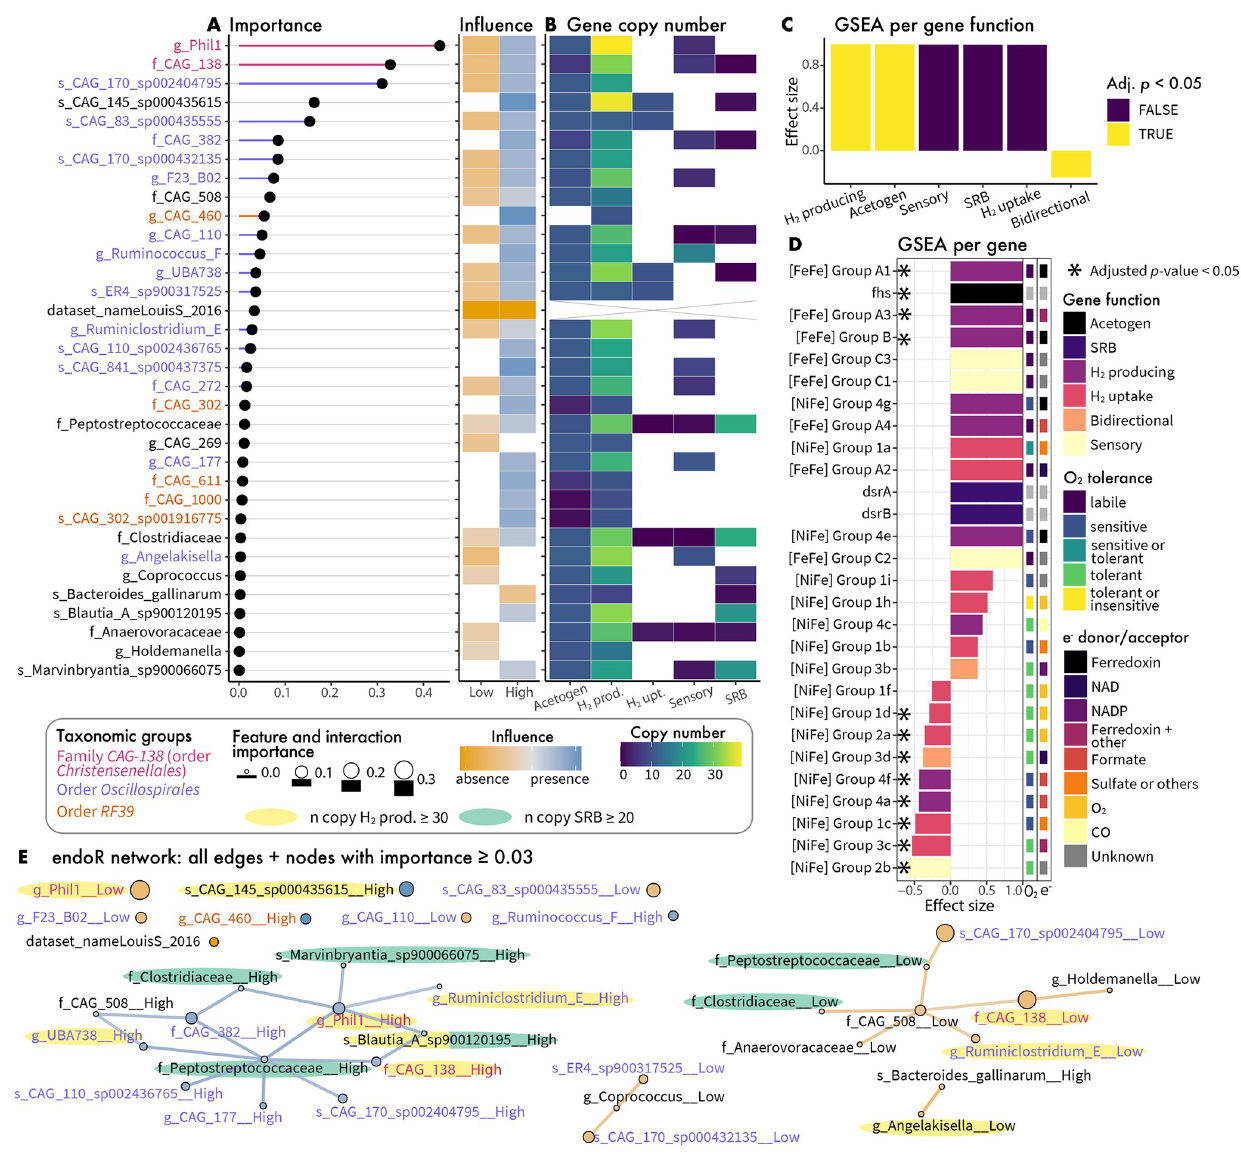
Fig 6. Relative abundances (RA) of Oscillospirales , Christensenellales and other select bacteria predict conditions favorable to colonization of the human gut by Methanobacteriaceae . A: Feature importance and influence for each taxa used by the decision ensemble generated by endoR. Taxonomic levels are indicated with label prefixes: ‘f_’ = family, ‘g_’ = genus, and ‘s_’ = species, while taxonomic orders are indicated via bar and label colors. Levels correspond to ‘Low’ and ‘High’ relative abundances of taxa. B: Sum of gene copy numbers of marker genes involved in H 2 production and consumption (see Methods and S5 Table), for endoR selected features. SRB: dsrA and dsrB genes exclusively involved in sulfate reduction [82]; Acetogen: fhs gene involved in acetogenesis [83]; other categories correspond to hydrogenases predicted functions as determined by the HydDB database: H 2 production (H 2 - prod.), H 2 uptake (H 2 -upt.), sensory [84]. Boxes are white for taxa for which genes were not detected in their genomes. The cross indicates ‘Non applicable’ (for the ‘dataset_nameLouisS_2016’ feature). C-D: Effect sizes from gene set enrichment analyses performed at the gene function (C/) or for each gene (D/), bars are colored by the adjusted p -values (Adj. p). D: Bars are colored by gene function. The predicted O 2 tolerance of hydrogenases and electron (e - ) donor or acceptor are indicated by colored boxes on the right of the plot [84]. Asterisks denote significance (adjusted p -value < 0.05). E: Decision network in which nodes correspond to individual features and edges correspond to pairwise interactions. Nodes and edges colors describe the feature and interaction influence; their sizes and widths are proportional to their importances. Nodes with an importance � than 0.3 but not connected are shown. Taxa with a gene copy number � 30 for H 2 production and � 20 for SRB genes are highlighted in yellow and green, respectively. The boxed legend applies to A, B, and E.